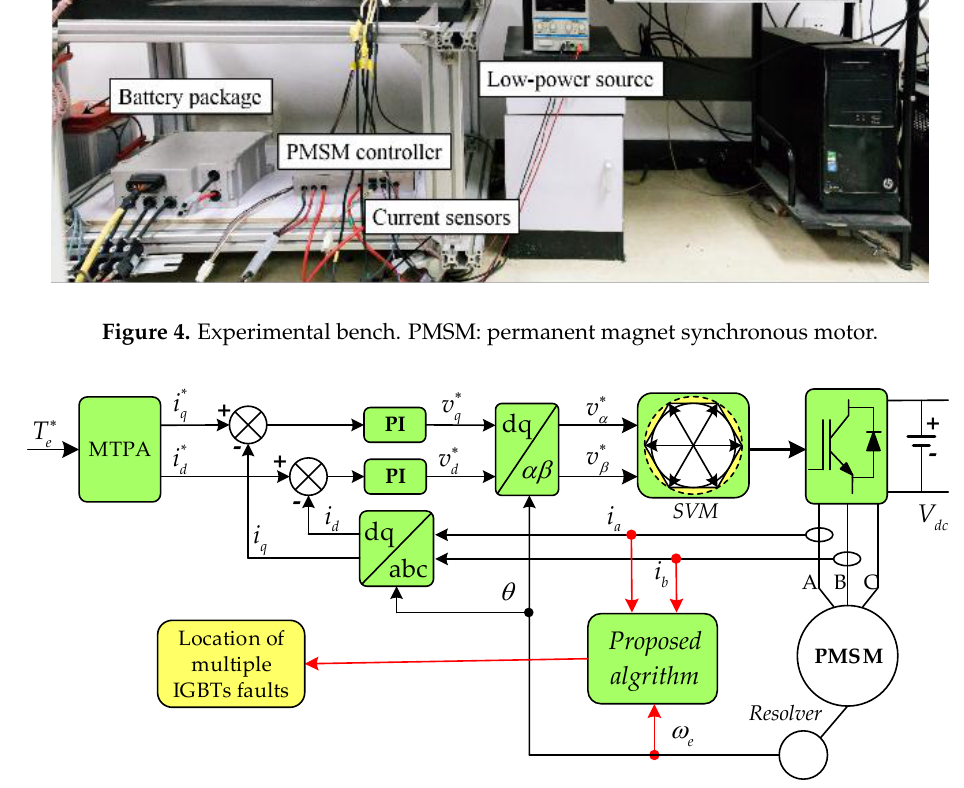
Figure 5. Diagram of drive system with open circuit fault diagnostic algorithm in experimental setup. Table 3. Parameters of used PMSM.